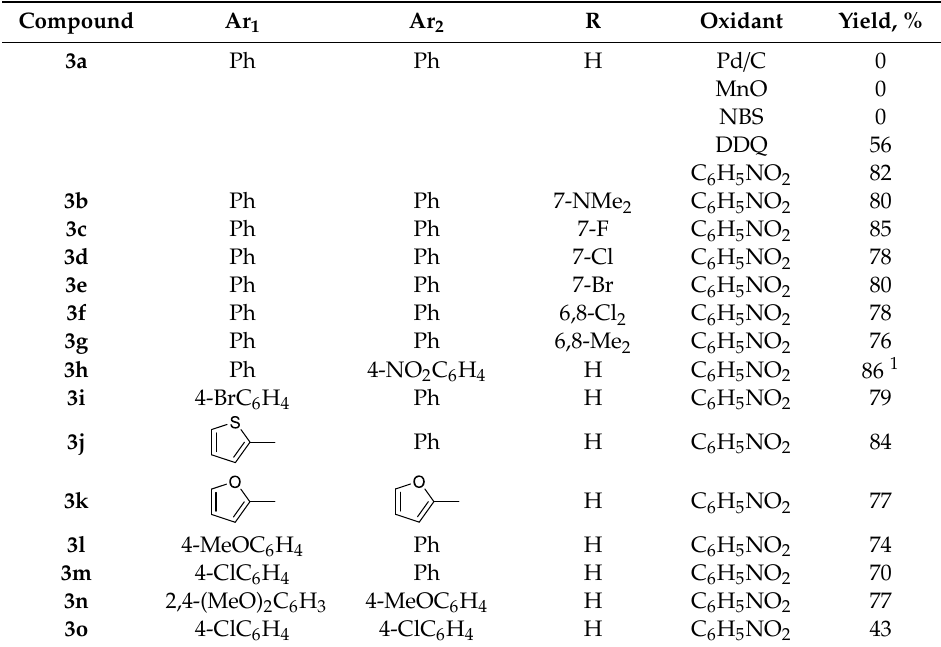
Table 3. Results of the aromatization of compounds 2 .